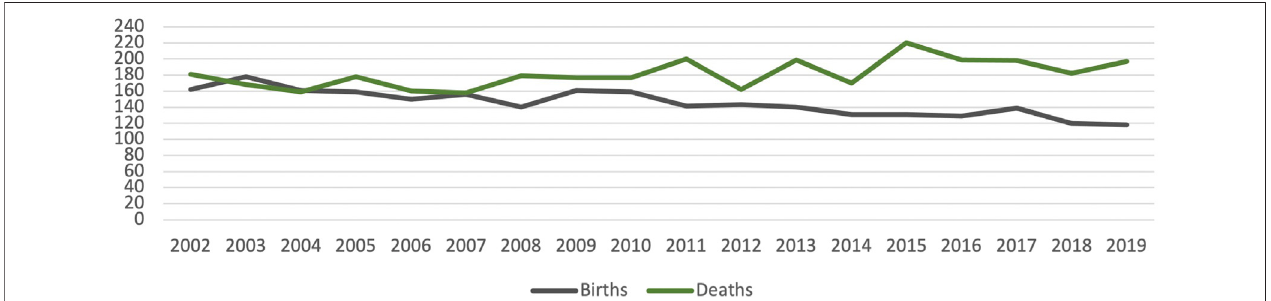
FIGURE 1 | Decreased birth-rate and deaths in Noci. Source: Istat — 1st January of each year.